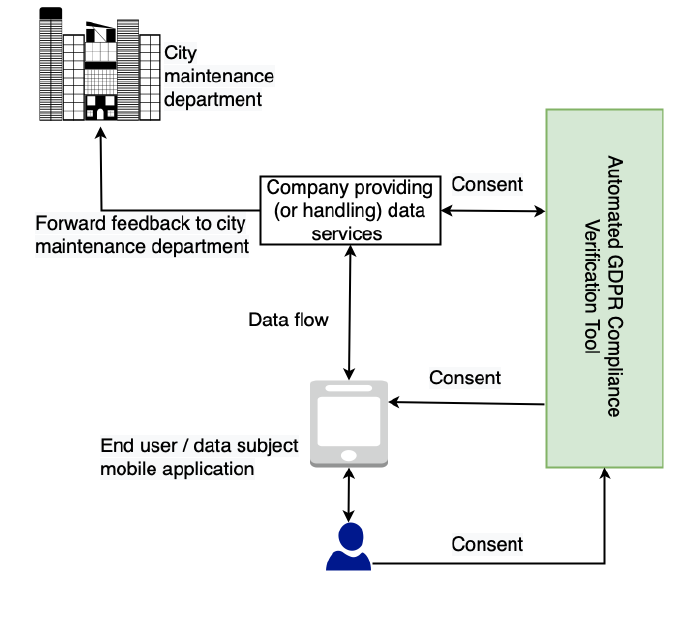
Figure A1. High-level overview of the insurance use case.